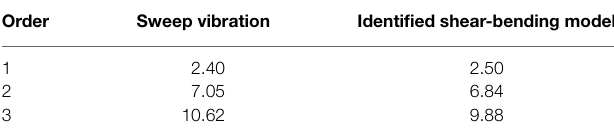
TABLE 6 | Comparison of natural frequencies (Hz).